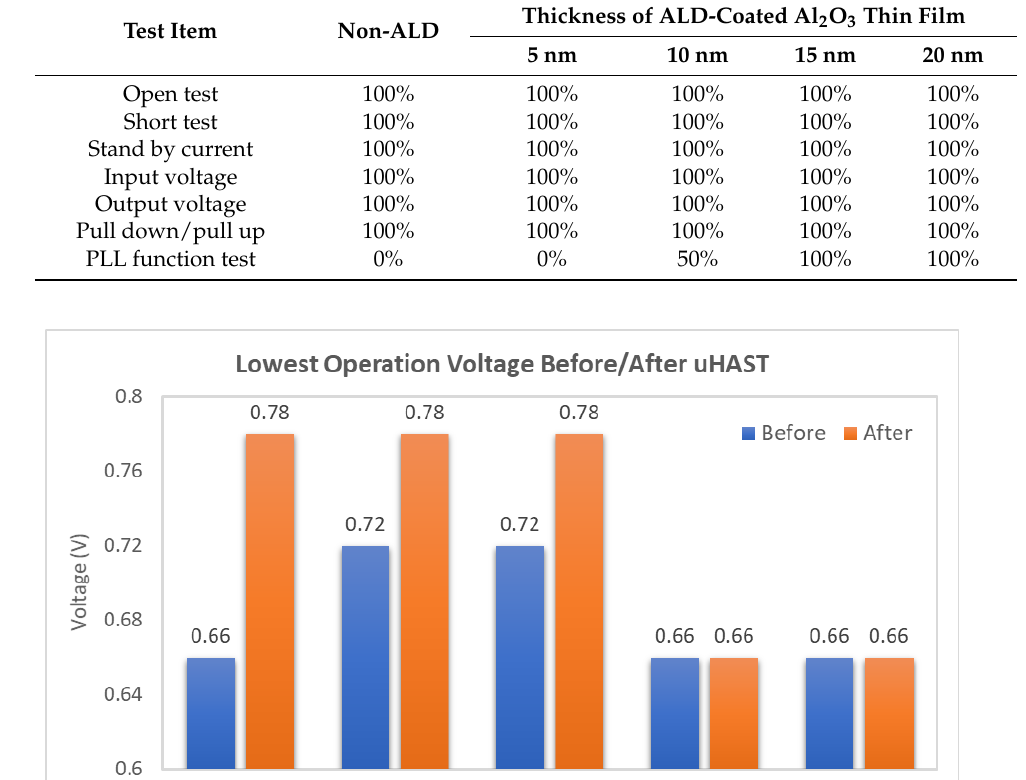
Table 2. The uHAST results as a function of Al 2 O 3 thickness.